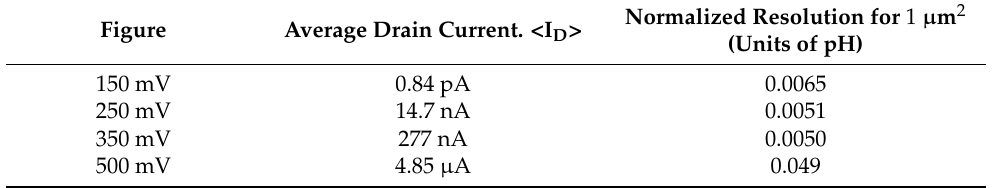
Table 2. ISFET resolution to pH normalized to the standard footprint area of 1 µ m 2 , calculated for different fluid gate biases and average drain current values. The rms voltage noise at the sensing layer is calculated using Equation (9), where the drain current noise PSDs is taken from Figure 12a. For the case with V mRE = 150 mV, we used the trace sampled with T S = 84 ms and integrated over the frequency range 0.1–1.5 Hz. For all other cases, we used the traces sampled at T S = 1 s and integrated over the range 0.0301–0.4975 Hz.